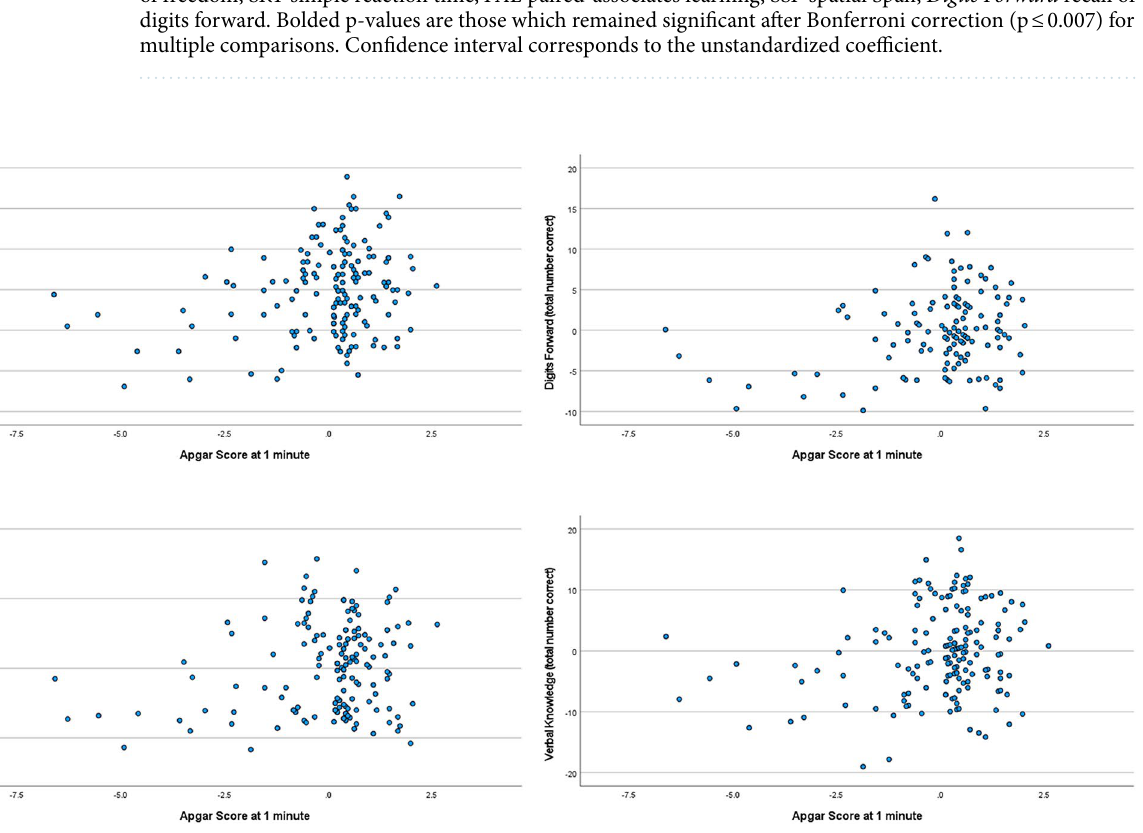
Figure 2. Partial regression plots representing the association between the Apgar score at 1 min (x-axis) and the following dependent variables (y-axis) from the top left to the bottom right: Riddles, Recall of Digits Forward, PAL(first trial memory score) and Verbal Knowledge, while adjusting for chronological age (CA) at time of cognitive testing. See that the score on cognitive variables (Y) increases as Apgar score (X 1 ) increases adjusting for chronological age (X2). PAL paired-associates